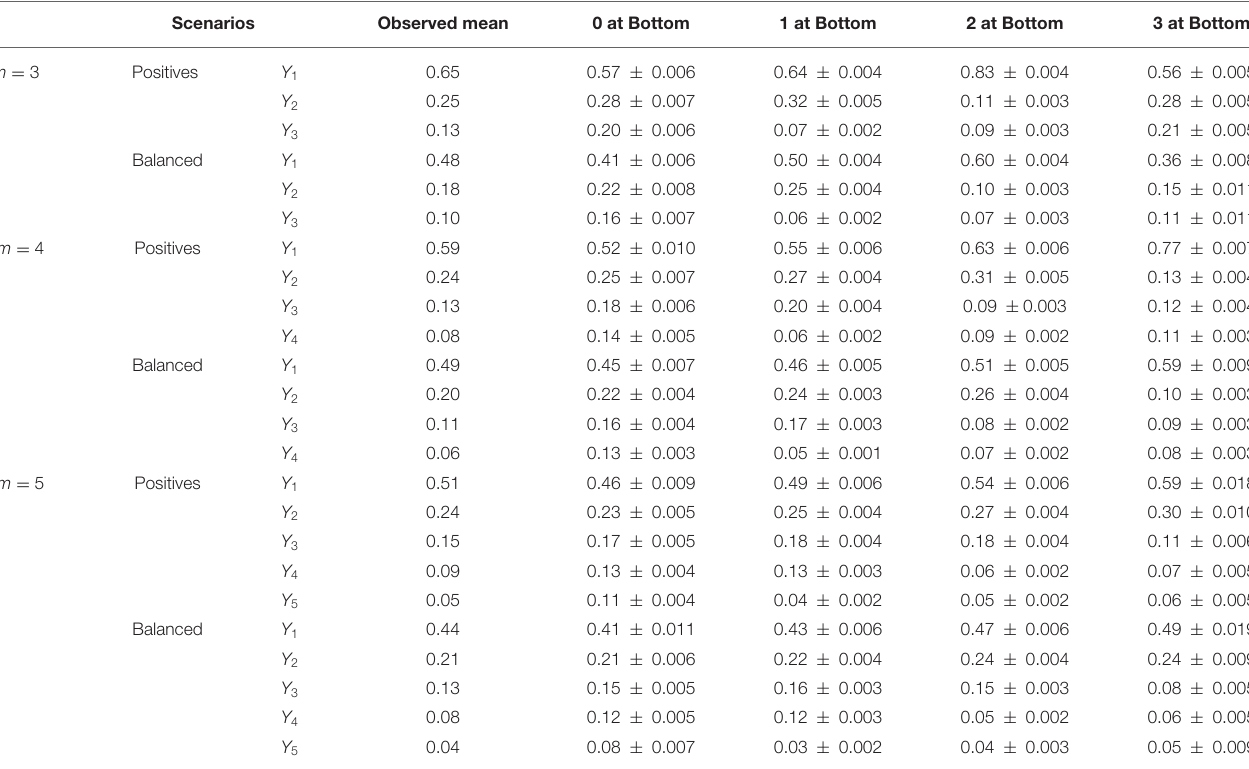
TABLE 2 | Estimation of counterfactual E [ Y i ( a )] along with 95 % confidence interval.